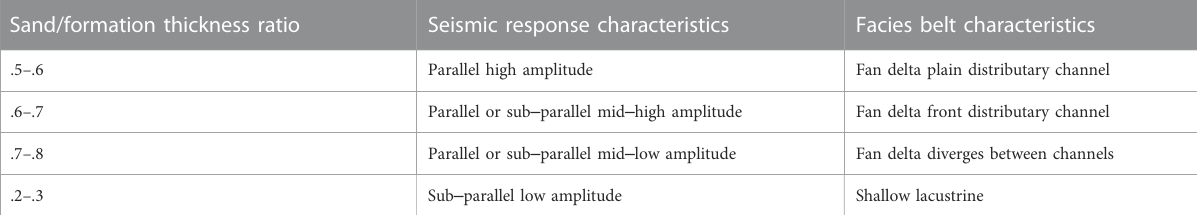
TABLE 2 Sand/formation thickness ratios, seismic response characteristics, and facies belt characteristics in the Aketao